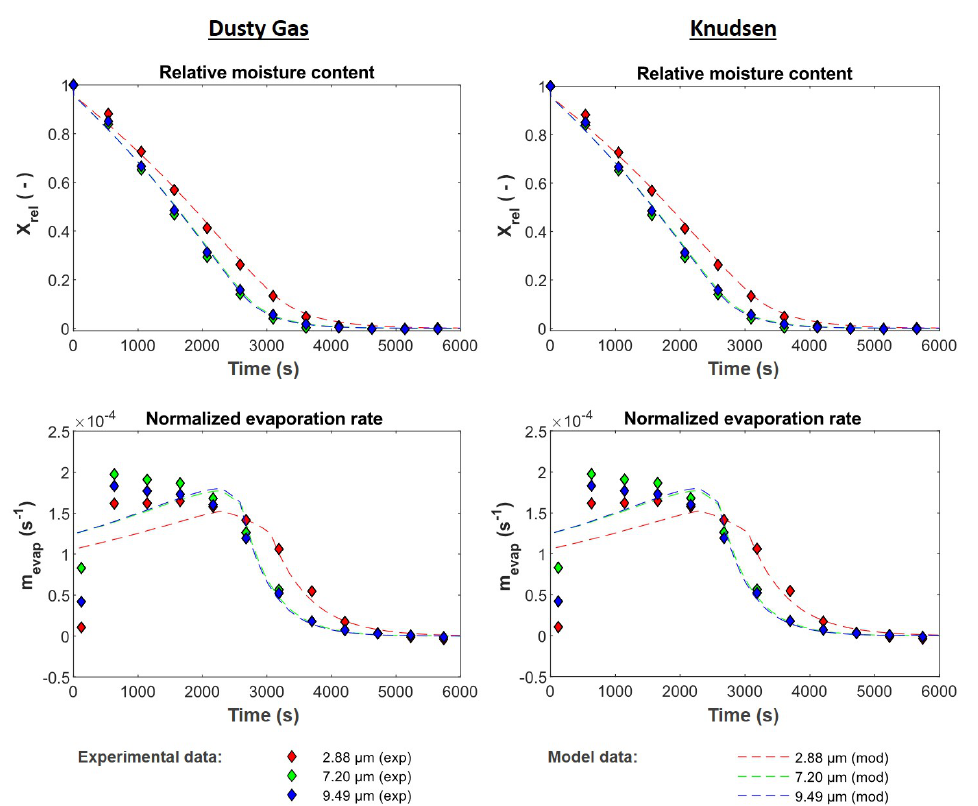
Figure 3. Validation of Knudsen model and dusty gas approach by means of experimental data during the freeze-drying of instant coffee granules by variation of pore